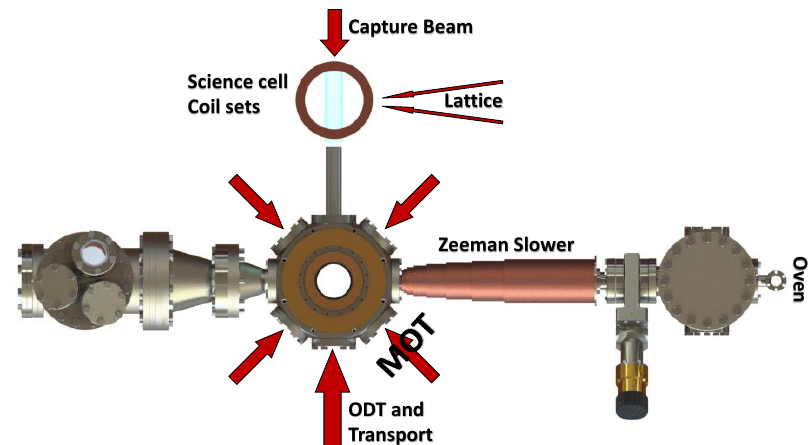
Figure 10: Experimental